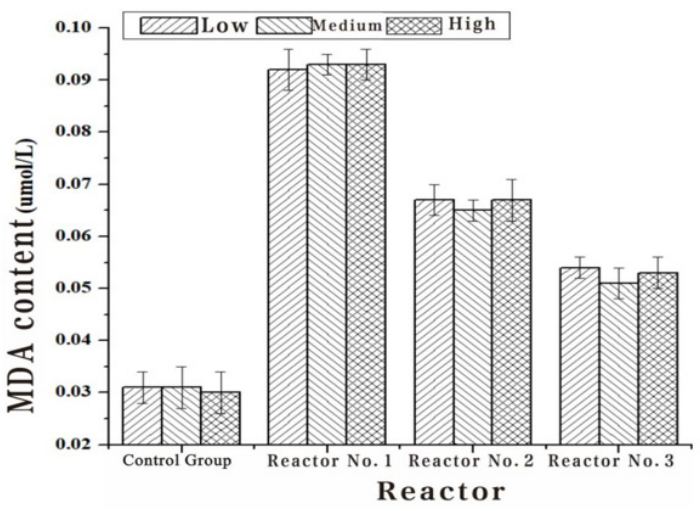
Figure 5. Effect of three addition methods with Phanerochaete chrysosporium on the MDA content.